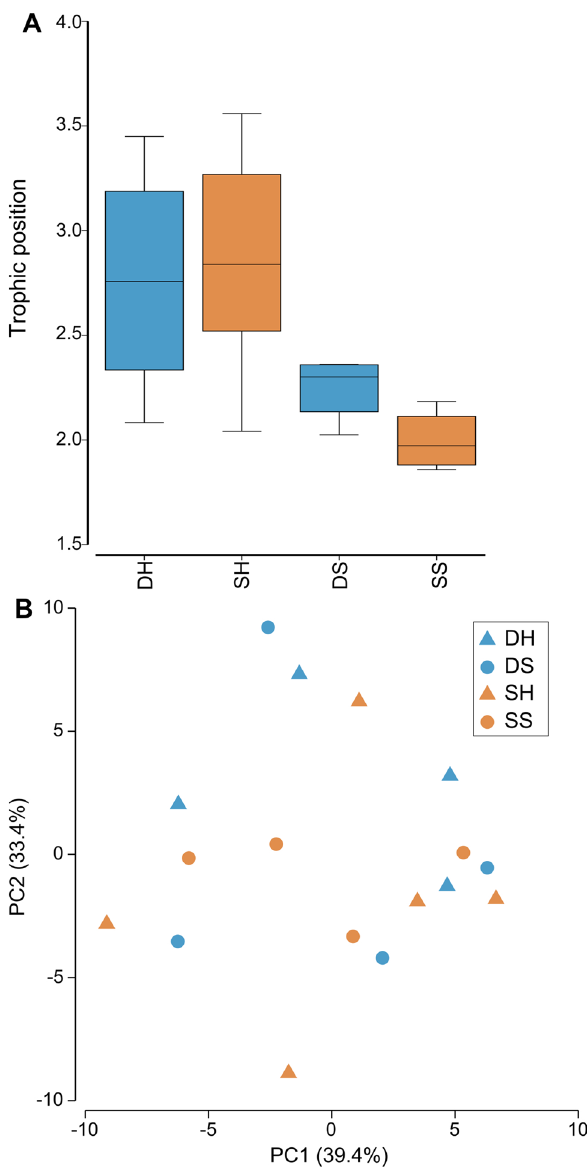
Figure 5. Calculated trophic position and carbon source of Oculina patagonica from 30 m (’Deep’, blue) and 2 m (’Shallow’, red) water depth. Sample are DH (deep host), DS (deep symbiont), SH (shallow host) and SS (shallow symbiont) ( A ) Calculated trophic position based on glutamic acid and phenylalanine nitrogen isotope. Horizontal black lines within boxes are median values and box limits represent 1st and 3rd quartiles. Whiskers represent 1.5 times the interquartile range. Round black points are individual sample data. ( B ) Carbon PCA of five essential amino acids (valine, leucine, isoleucine, methionine, and